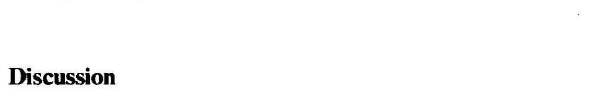
Figure 8. Proposed mechanism of the introduction of methyl groups into the pteridine moiety of methanopterin. SAM, S